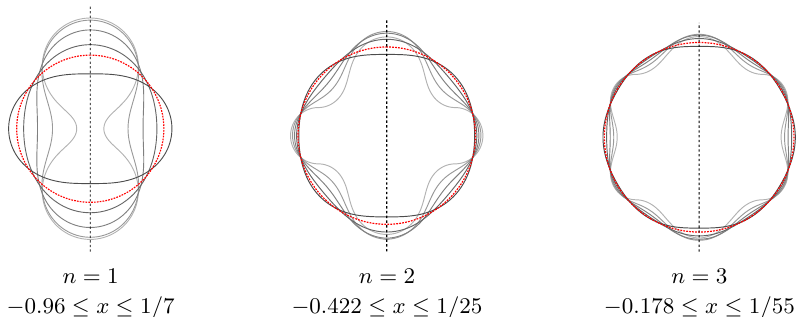
Figure 2 . Axisymmetric embeddings of the geometries (2.7) in R 3 for n = 1 , 2, and 3 for the range of x for which embeddings exist; the full geometries are surfaces of revolution obtained by rotating about the dotted vertical line. The red dotted circle represents the round sphere x = 0 , while the other curves show even spacings in x ; lines go from light to dark with increasing x , with only the black lines corresponding to positive x . At positive x , embeddings fail to exist for x > 1 / (1 + 6 n 2 ) , correspondng to the Ricci curvature becoming negative at the poles (no axisymmetric embedding can have negative curvature at the poles). For negative x , corresponding to the lighter gray lines, the smallest values of x for which embeddings exist is determined numerically, except for the case n = 1 for which embeddings exist all the way to x = − 1 when the sphere pinches off into two pieces (the lowest value x = − 0 . 96 shown here is the smallest value of x reached in the numerics discussed in section